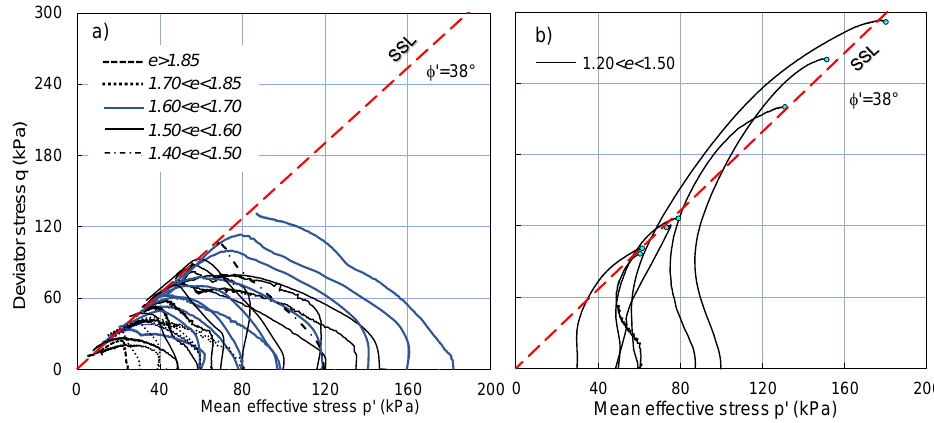
Figure 4. Results of triaxial compression tests on isotropically consolidated specimens (CIU_c tests) on reconstituted specimens of Cervinara ash: ( a ) brittle response; ( b ) ductile response.